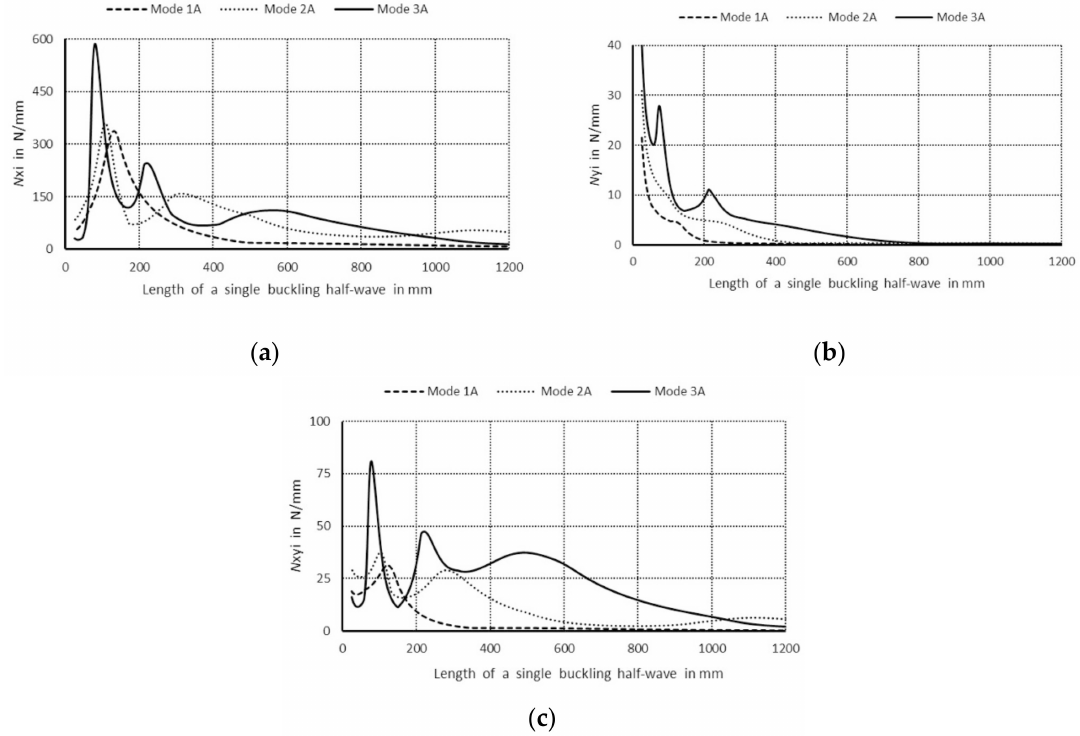
Figure 13. Maximal absolute values of membrane forces in N/mm for anti-symmetrical buckling modes: ( a ) longitudinal forces N xi , ( b ) transverse forces N yi and ( c ) shear forces N xyi as a function of the length of a single buckling half-wave in